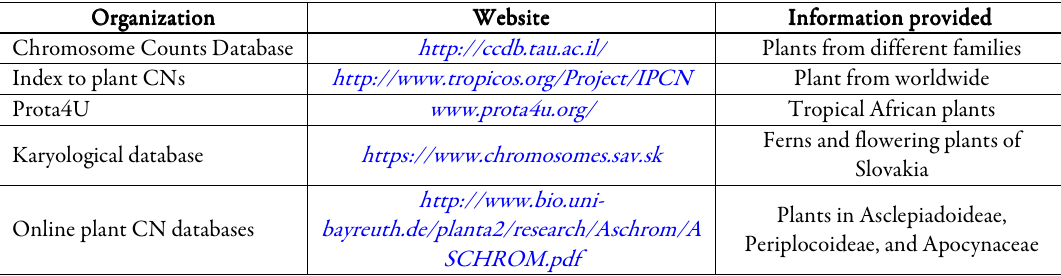
Online databases for taxonomic classification in